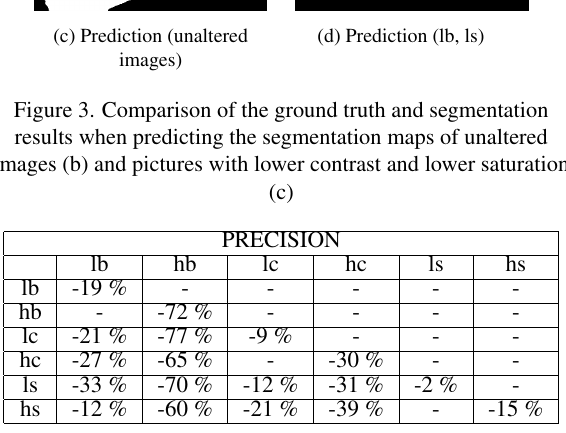
Table 3. Precision precentage values when using altered images in comparison to precision values when using original, unaltered images